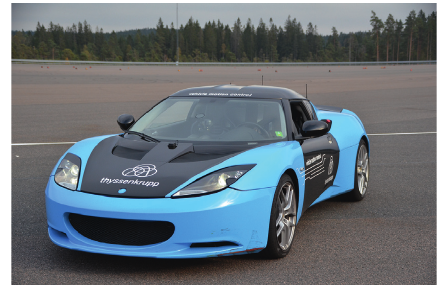
Figure 7: The autonomous test vehicle.